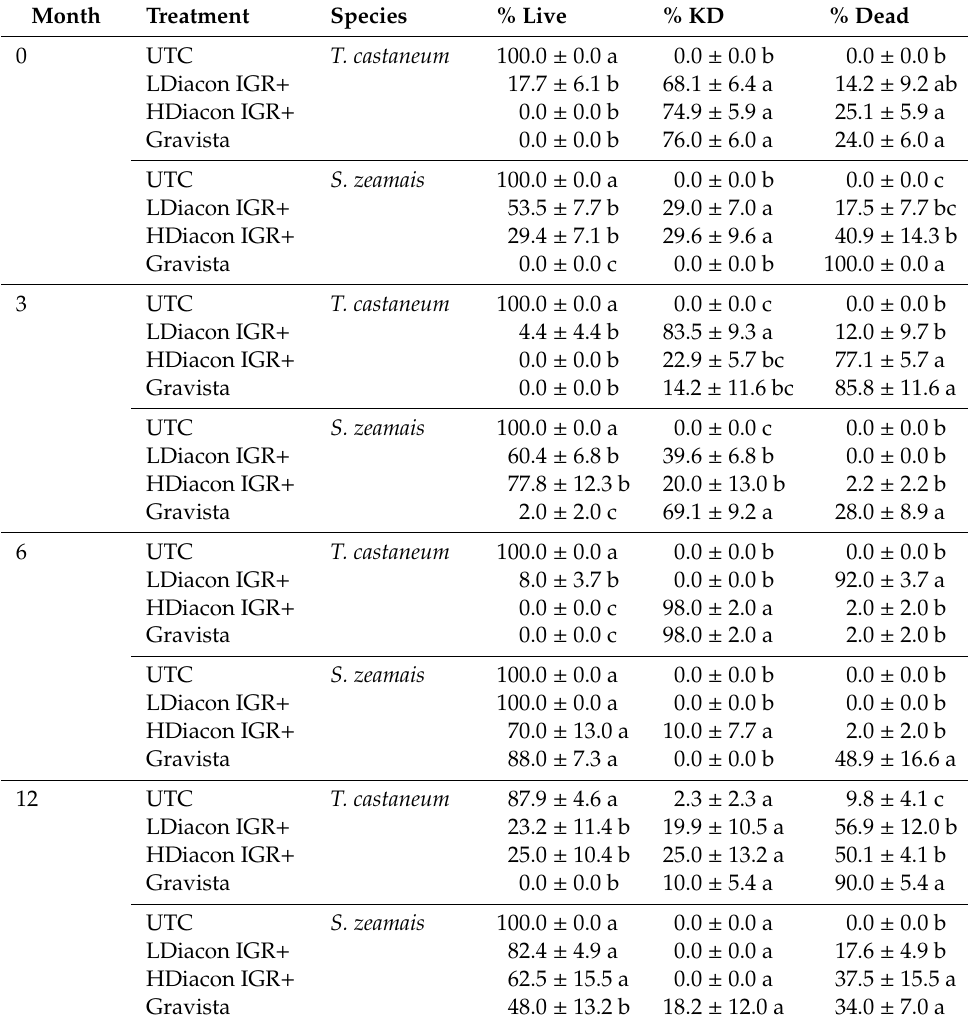
Table 7. Percentage (means ± SE) of T. castaneum and S. zeamais alive (Live), knocked down (KD), or dead (means ± SE) seven days after exposure on untreated corn (UTC) or on corn treated with the low rate of Diacon IGR + (LDiacon IGR + , 0.5 ppm deltamethrin + 1.25 ppm methoprene), the high rate of Diacon IGR + (HDiacon IGR + , 1.0 ppm + 2.5 ppm), or the Gravista (methoprene + deltamethrin + piperonyl butoxide synergist). Data are separated by month, bioassays were done at 0 months (1 day), and 3, 6, 9, and 12 months after treatment 1,2